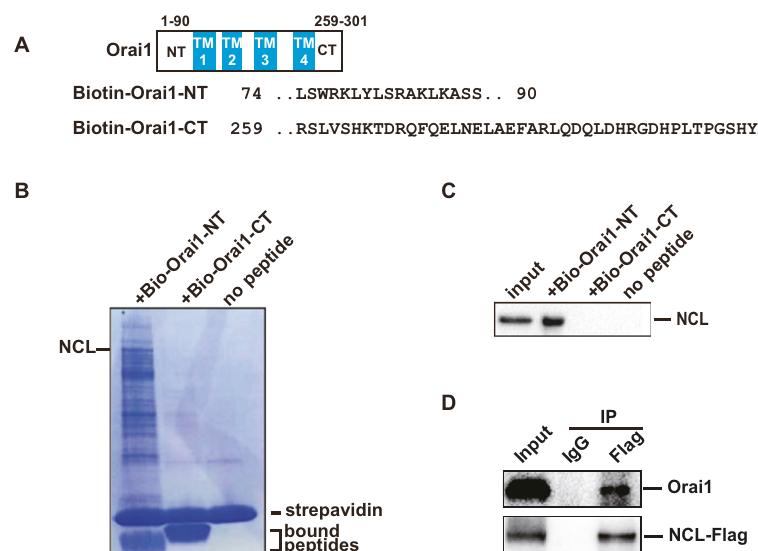
Fig. 1 Identi fi cation of NCL as a novel interaction partner of Orai1. A Domain structures of Orai1 and the synthetic polypeptide sequences of Orai1 terminal. B Biotinylated Orai1 peptides were immobilized onto streptavidin beads then mixed with MCF-7 cell lysate to capture the interaction proteins. The samples were analyzed by SDS-PAGE and followed by mass spectrometry. C As in B, the pull-down proteins were analyzed by western blotting using anti-NCL antibody. D Co-IP assay was performed using MCF-7 cell lysate transfected with NCL-Flag plasmid to test the interaction between Orai1 and NCL. Orai1 was immunoprecipitated from the cell lysate using Flag antibody, and the immunoprecipitated materials were detected by western blotting using anti-Orai1 and anti-Flag antibody. Mouse IgG was used as a negative control in the immunoprecipitation